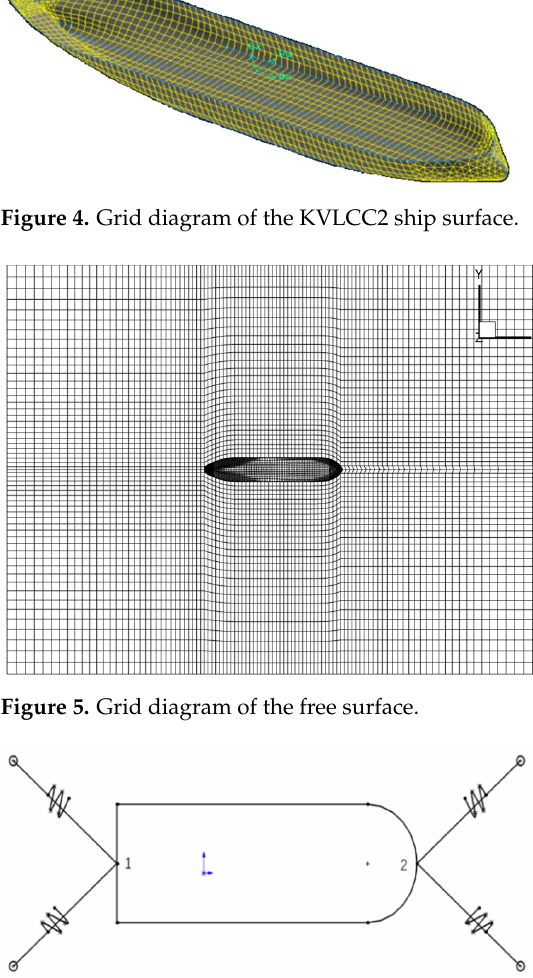
Figure 6. Schematic diagram of the horizontal soft spring.